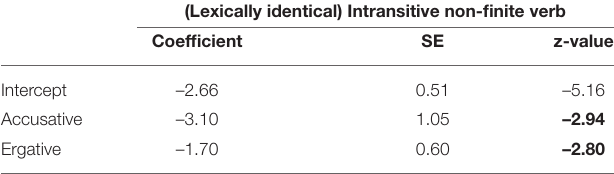
TABLE 7 | Glmer results for the (Identical) Intransitive Non-finite verb in the three conditions for Experiment 2. The analysis uses treatment contrast, with the Locative condition as the baseline with the coefficient signifying the difference from the